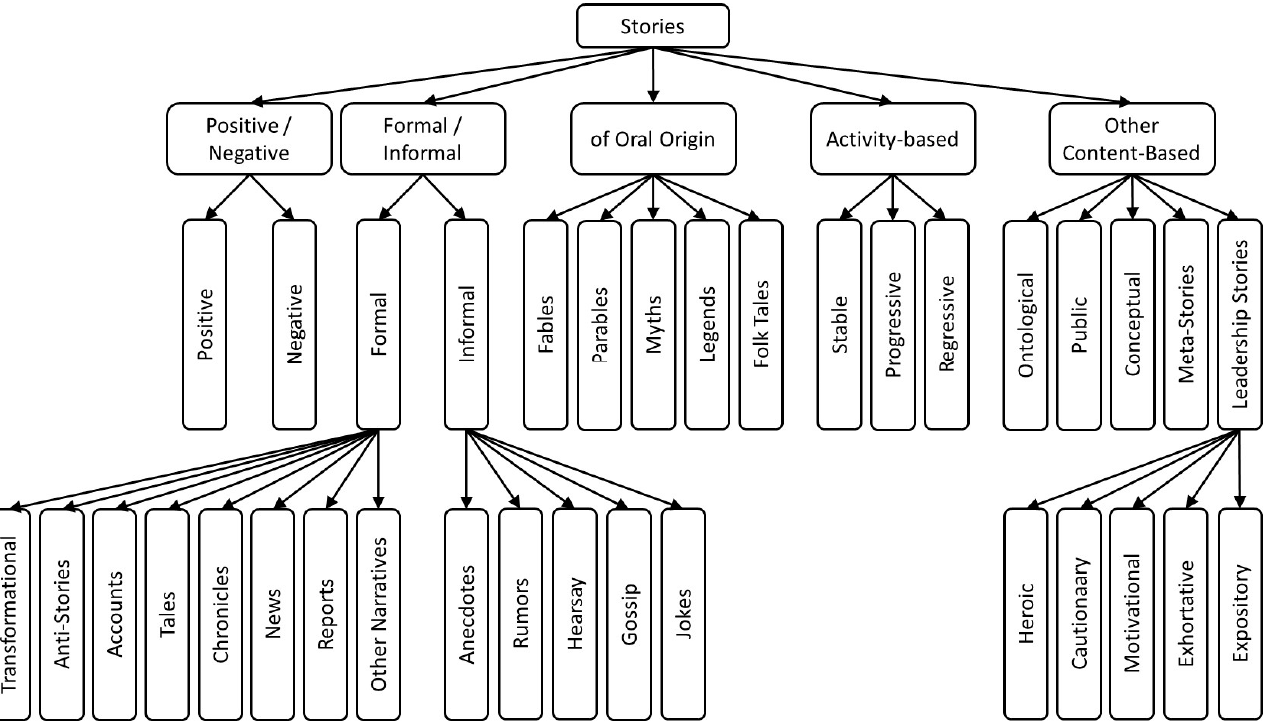
Figure 2. Taxonomy of Stories that can be utilized in Storytelling.